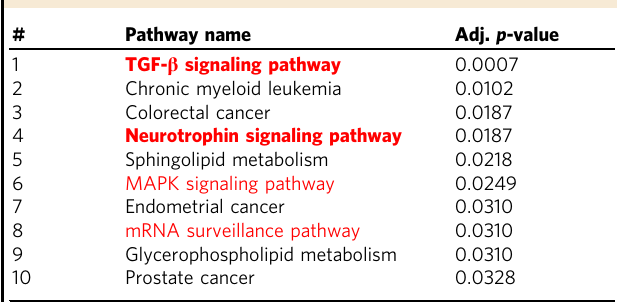
Table 1 Enriched KEGG pathway terms in intersection of miR-128 and Arpp21 target